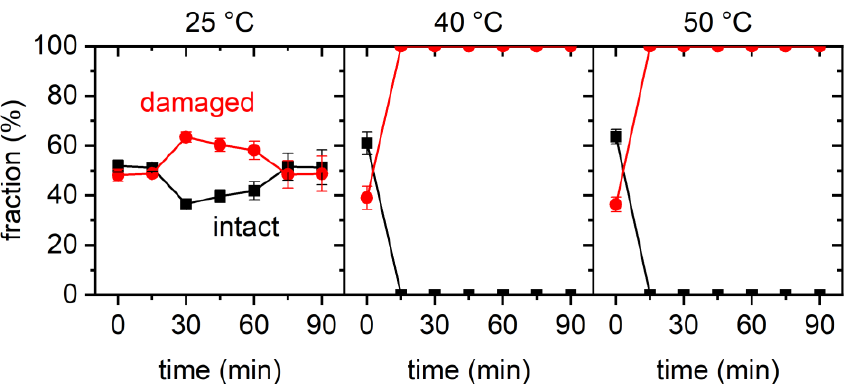
Figure 6. Results of the statistical analysis of the AFM images for 2 M GdmSCN. Each data point represents the average of three AFM images with the standard deviations given as error bars.